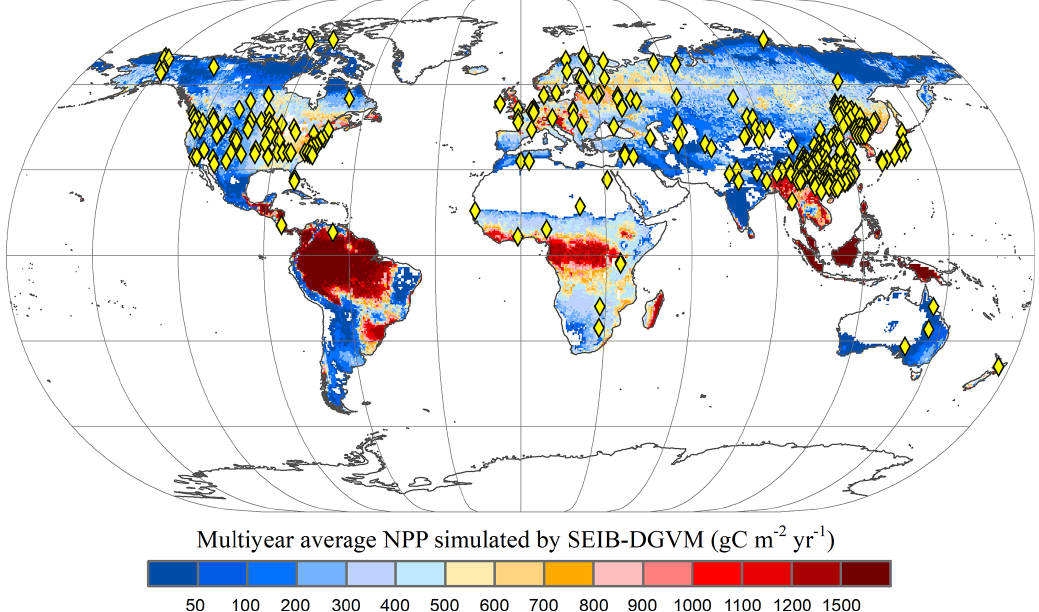
Figure 2. Multiyear average NPP simulated by SEIB-DGVM and EMDI global site distribution. Yellow rhombuses indicate the monitoring stations of the